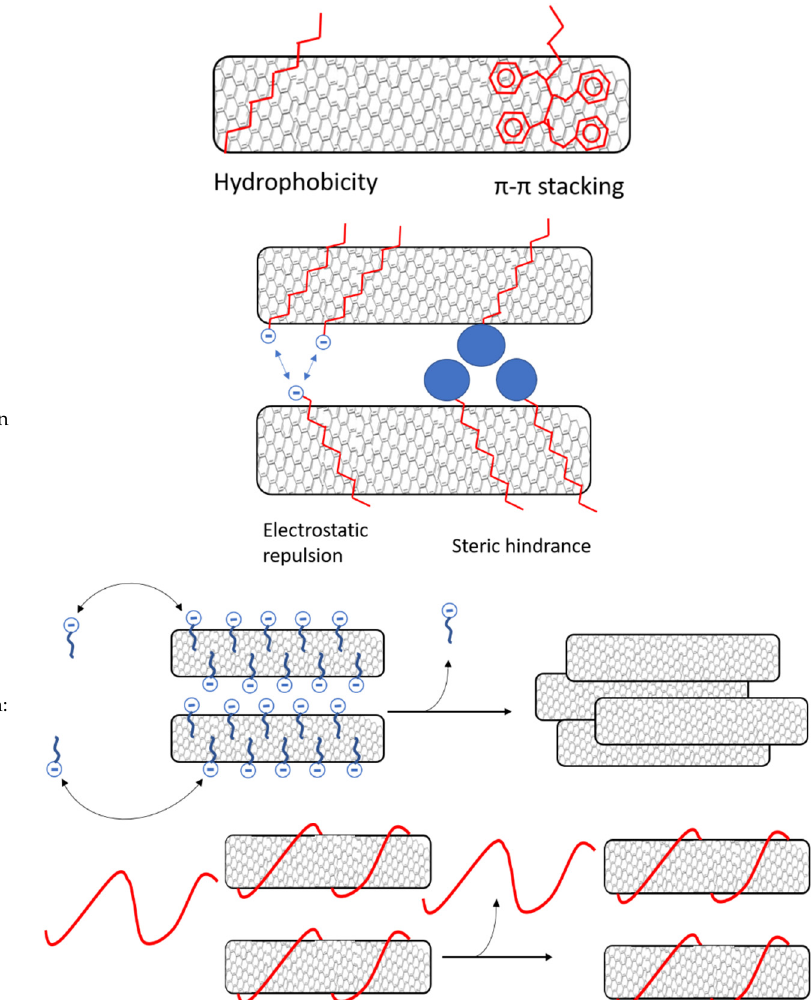
Figure 1. ( a ) Affinity of a dispersant for nanotubes can be provided by hydrophobicity, but even better by π -conjugated compounds that can stack on the nanotubes by π - π interactions. ( b ) There are two mechanisms that can prevent nanotube reaggregation. Firstly, electrostatic charges on the dispersant that repulse dispersants on other nanotubes. Secondly, bulky groups can hinder nanotubes from